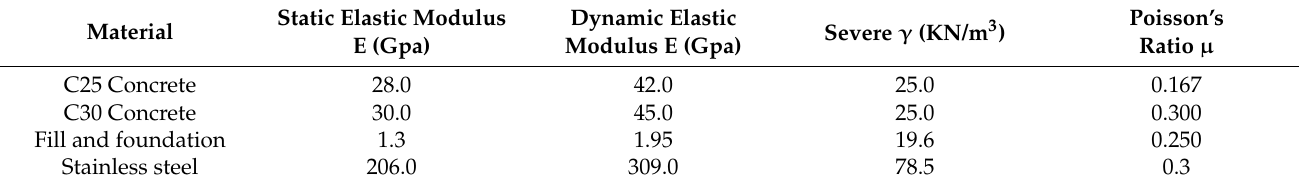
Table 1. Material Table 1. Material parameters.